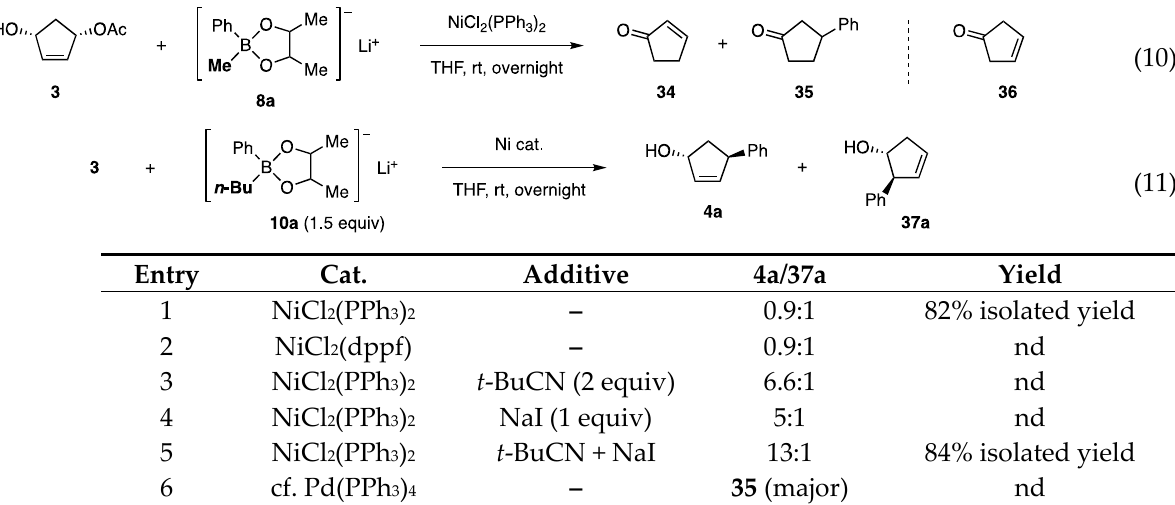
Scheme 8. Reaction of cyclopentenyl acetate 3 with borates 8a and 10a 1 . 1 Diol ligand consisted of dl- and meso-forms at a 4:1